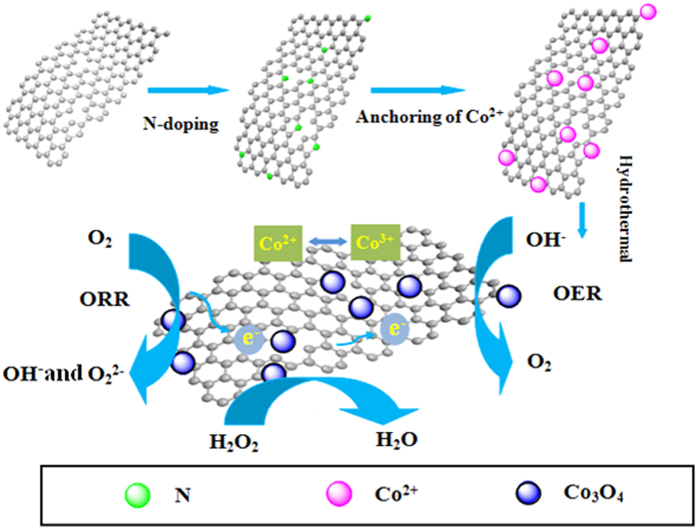
Schematic illustration of the synthesis of Co3O4/N-rGO.